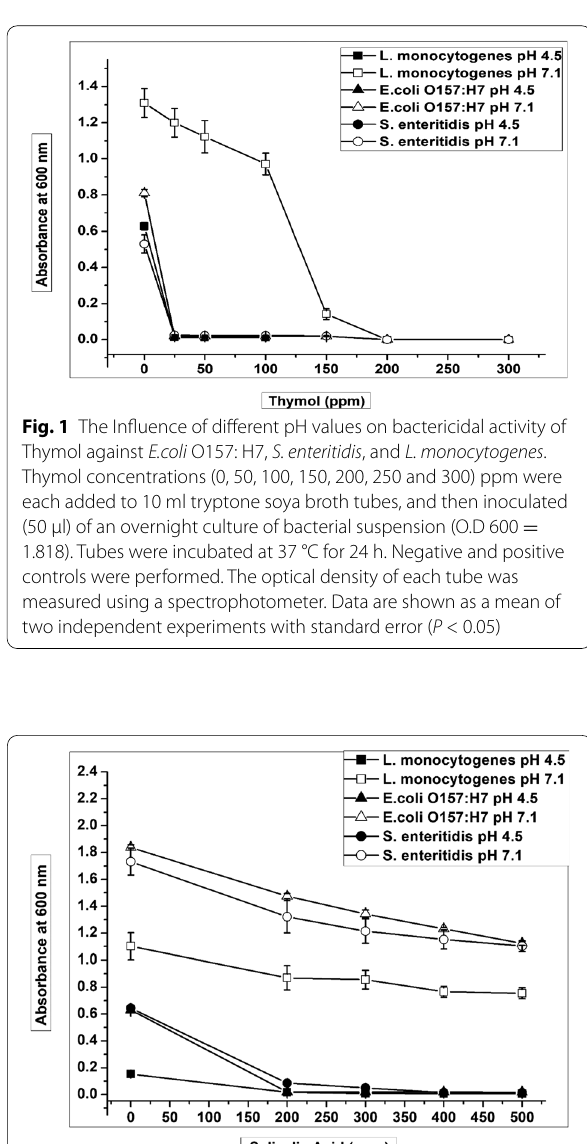
Fig. 2 The Influence of different pH values on bactericidal activity of salicylic acid against E.coli O157: H7, S. enteritidis , and L. monocytogenes . Salicylic acid concentrations (0, 20, 40, 60, 80, and 100) ppm were each added to 10 ml tryptone soya broth tubes, and then inoculated (50 μl) of an overnight culture of bacterial suspension (O.D 600 1.818). Tubes were incubated at 37 °C for 24 h. Negative = and positive controls were performed. The optical density of each tube was measured using a spectrophotometer. Data are shown as a mean of two independent experiments with standard error ( P <